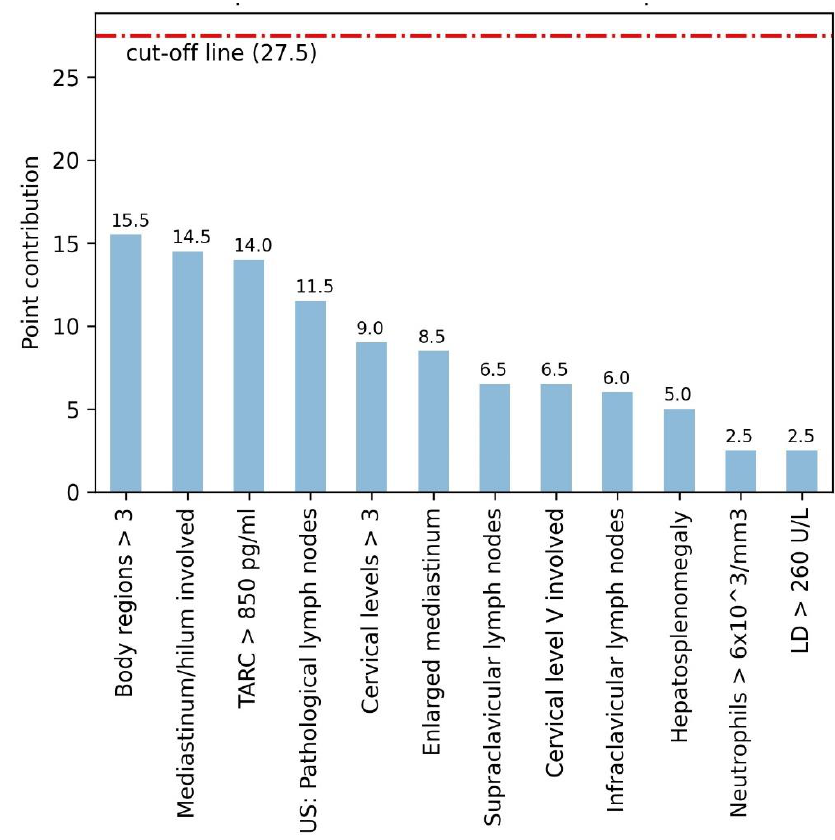
Figure 2. Factors included in the final multivariate scoring model with their weighing factors. The blue columns represent the weighing factors of the variables. The red line represents the cut-off